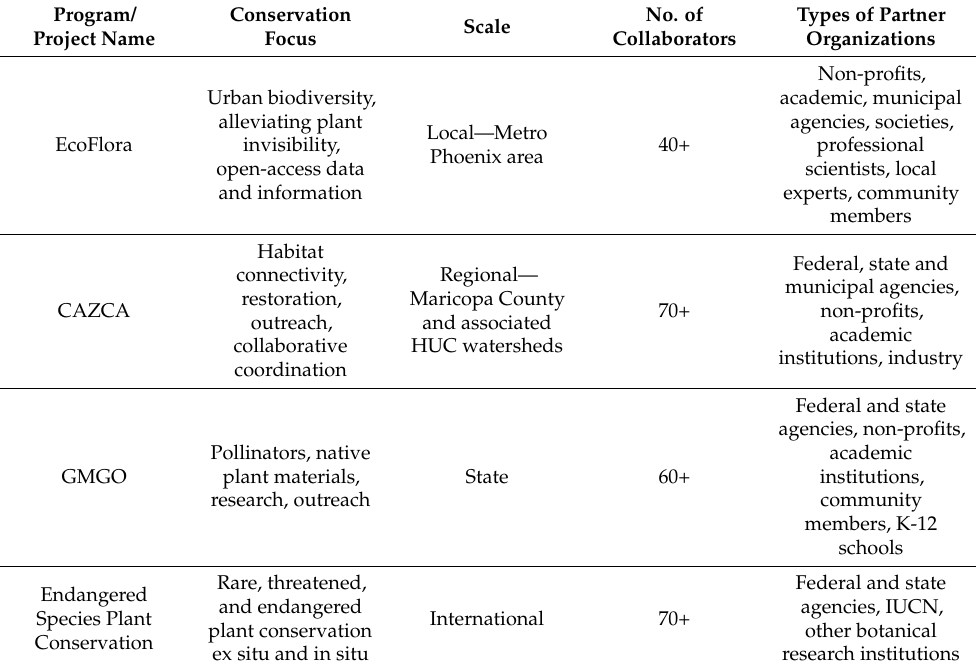
Table 1. Summary of DBG case study